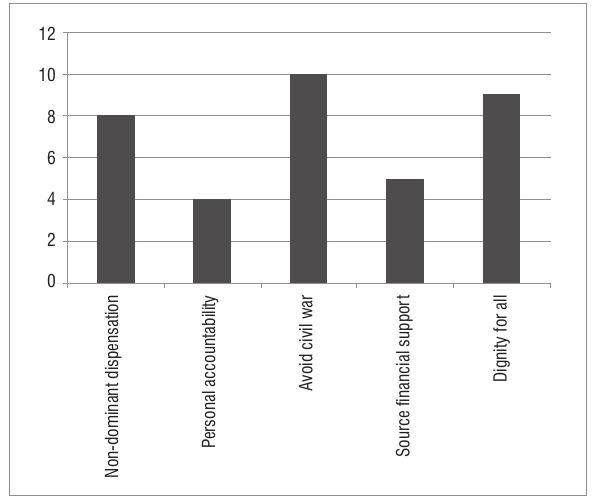
Figure 4: Number of occurrences of themes supporting optimism.